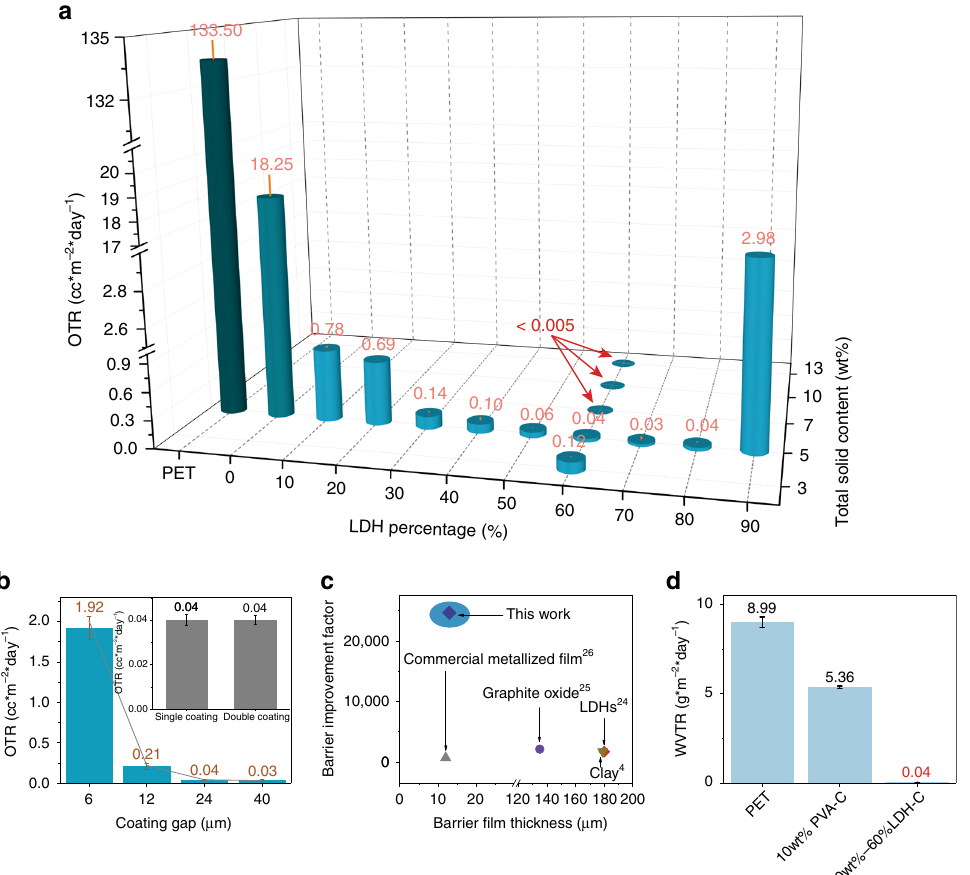
Fig. 3 Barrier properties of coated fi lms. a OTR plot against LDH% in the coating layer and total solid content of the coating solutions. The fi lms were coated with 24 μ m gap. b OTR plot against coating gap and the inset shows that the OTR values are very similar by coating a substrate with the same coating layer thickness (a single and double coating process). The grey line is a guide to the eye. The coating solution used to coat all the fi lms contains 3 wt% LDH NS and 2 wt% PVA. c Barrier improvement factor plot against barrier fi lm thickness: Comparison of this work and other works with LDH 29 , clay 4 , and graphite oxide 30 as fi ller and commercial metallised fi lm 31 . d WVTR of the crosslinked barrier fi lm at 10 wt% total solid content where PVA-C and LDH-C indicates that the PVA component was crosslinked by TSMP. PVA MW of 67,000 g mol − 1 was used to obtain the data in a – c , PVA MW of 195,000 g mol − 1 was used to obtain the data in d . Error bars represent the standard deviations from more than two measurements. Source data